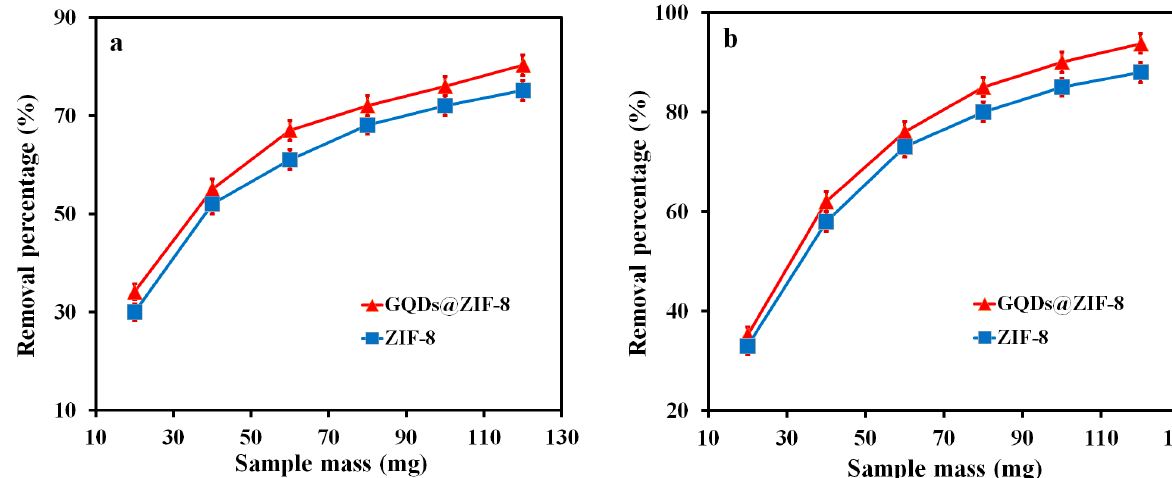
Figure 8. Effect of adsorbent mass on the removal percentage of toluene ( a ) and ethyl acetate ( b ). The influence of the pH value on the removal percentage of ZIF-8 and GQDs@ZIF-8 is shown in Figure 9. In this measurement, the sample mass of 100 mg, toluene concentration of 400 mg/L, ethyl acetate concentration of 800 mg/L, adsorption time of 180 min and pH value of 3, 5, 7, 9 and 11, respectively, were applied. It is obvious that both samples have a special response to the pH value of the toluene and ethyl acetate solution. Both acidic and basic conditions enhance the removal percentages of toluene and ethyl acetate, which is mainly due to the protonation and deprotonation of active sites at the edge of GQDs. As a kind of nanomaterial with a conjugated structure, GQDs contain abundant dissociable groups such as amino groups, carboxyl groups and hydroxyl groups on the surface, and the degree of dissociation directly depends on the pH value of the solution. The hydroxyl groups and imidazole groups in ZIF-8 can combine to form hydrogen bonds, which lead to the formation of new pore channels, thereby increasing the adsorption ability of the composites. In addition, the abundant functional groups on the surface also provide numerous active sites, which are favorable for binding with adsorbate molecules.